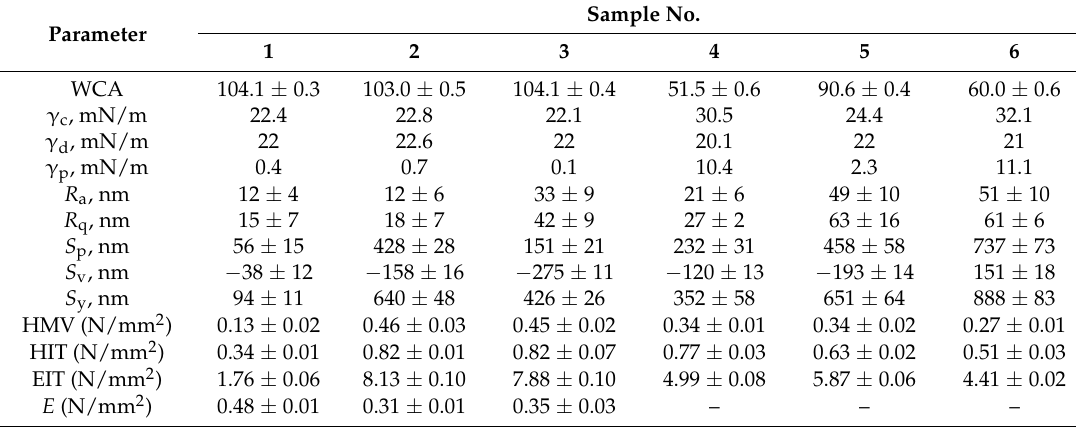
Table 1. Surface physical-chemical characteristics: water contact angle (WCA), surface energy ( γ c ) and its disperse ( γ d ) and polar ( γ p ) components; surface roughness ( R a , R q , S p , S v , S y ) and physical-mechanical parameters: dynamic Vicker’s hardness (HMV), indentation hardness (HIT), indentation elastic modulus (EIT), and elastic modulus ( E t) of the studied coatings: (1) control (6 wt % ES40,without PEG-silane); (2) (4 wt % ES40 + 2 wt % PEG-silane); (3) (6 wt % ES40 + 2 wt % PEG silane); (4) (4 wt % ES40 + 2 wt % PEG-silane + 0.5 wt % NIS); (5) (4 wt % ES40 + 2 wt % PEG-silane